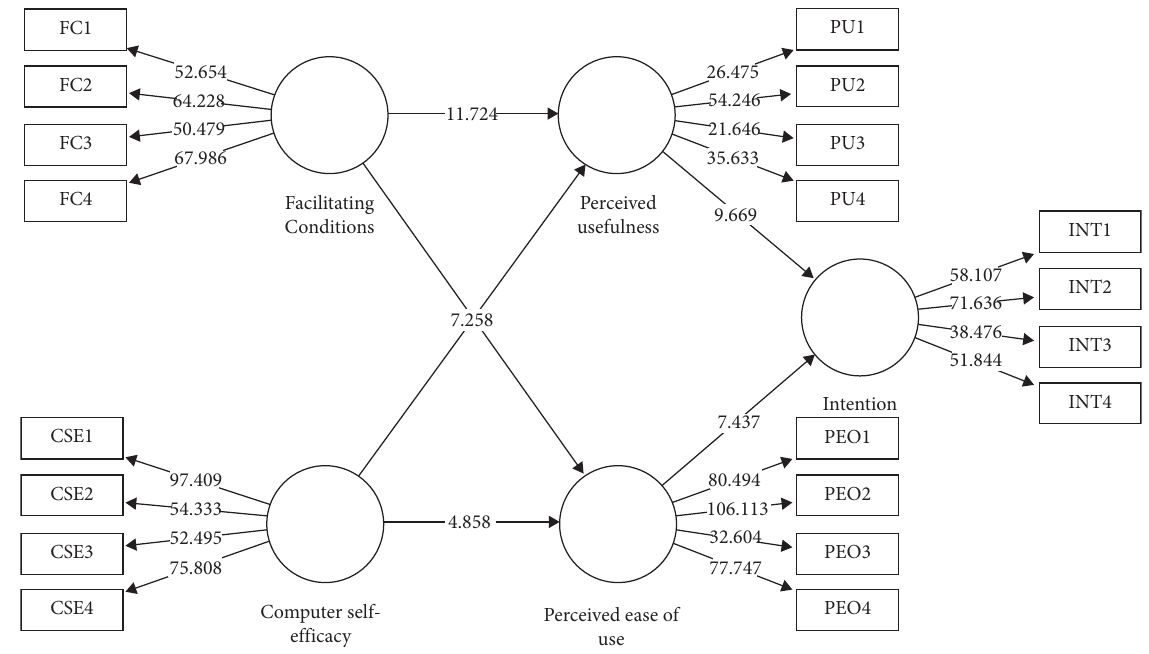
Figure 3: Structural equation model. Table 5: Hypotheses assessment summary.